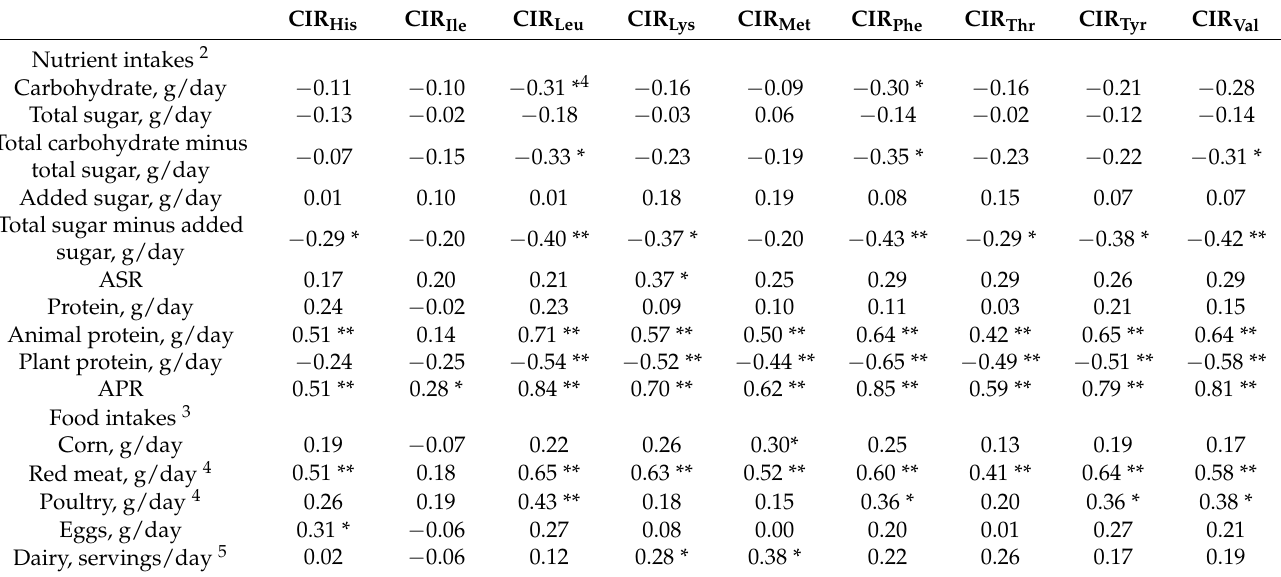
Table 3. Correlations of essential amino acid CIRs with 15-day mean dietary intakes ( n = 99) 1 . CIR